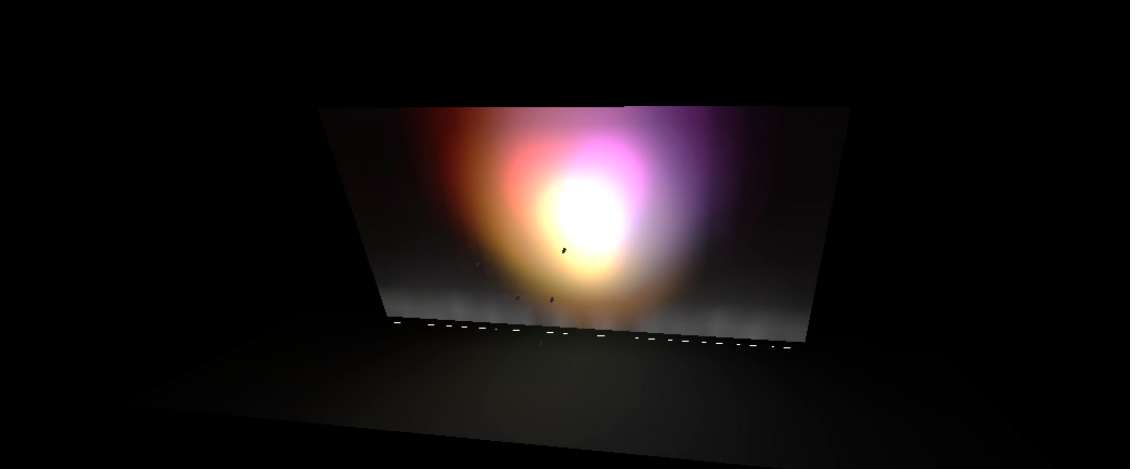
Figure 12. Simulation of visual result of Working Diagram I—Scene 7.